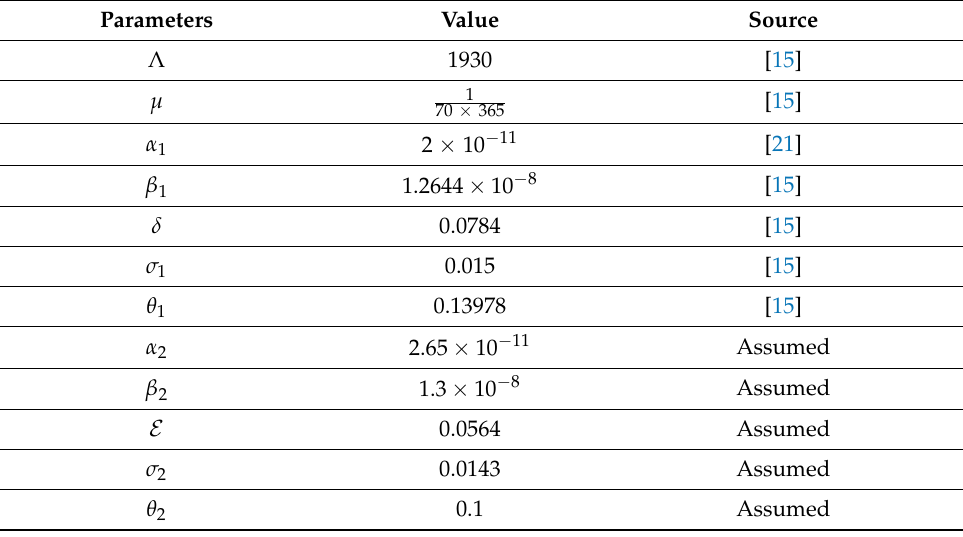
Table 2. Parameter values of the COVID-19 model with two